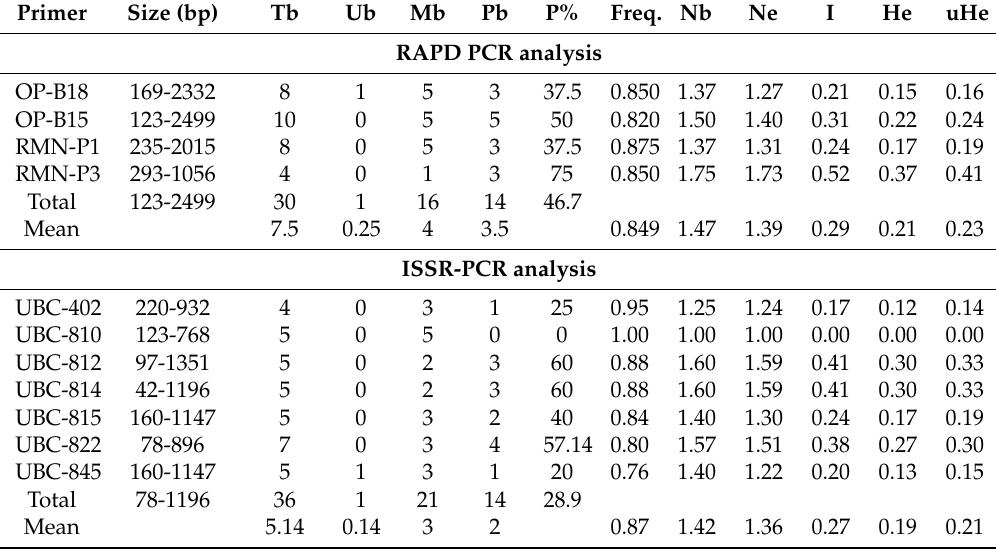
Table 6. Details of marker parameters calculated for RAPD and ISSR